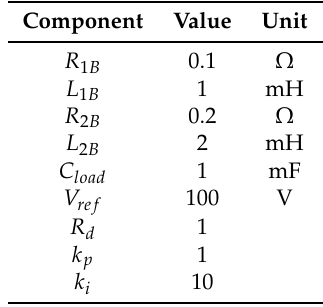
Table 1. Microgrid parameter